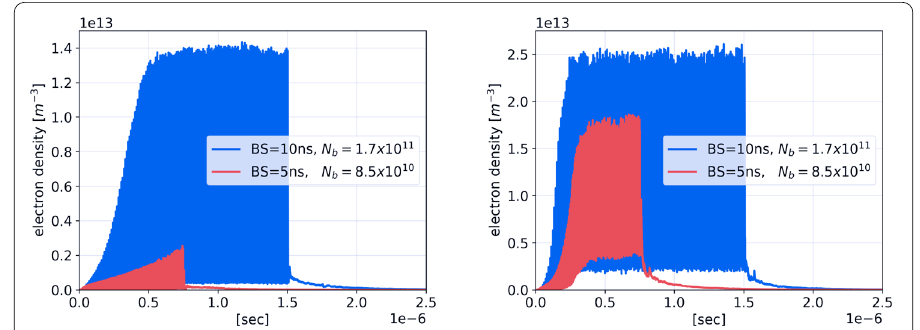
Figure 7 Time evolution of the central electron density for bunch spacings of 10 and 5 ns, with associated bunch population N b = 1.7 × 10 11 m –3 and 8.5 × 10 10 m –3 , respectively, at a high electron generation rate of n (cid:4) γ = 10 –3 m –1 (BS:bunch spacing, N b : bunch population). leftfigure : SEY = 1.1, rightfigure : SEY =